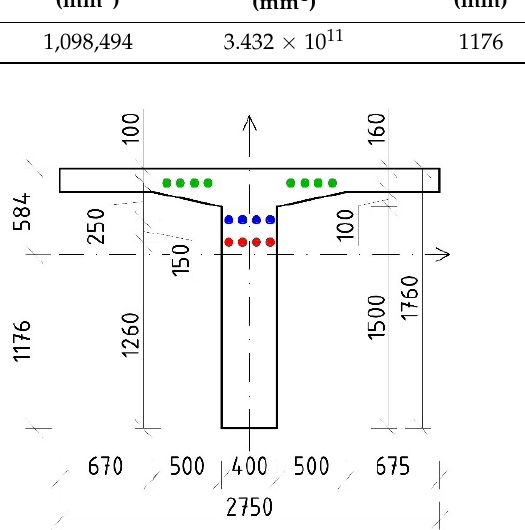
Table 4. Ideal cross-sectional characteristics (2.50 m from the strut). Figure 22. Ideal cross-section of the investigated beam (2.50 m from the strut), dimensions are in